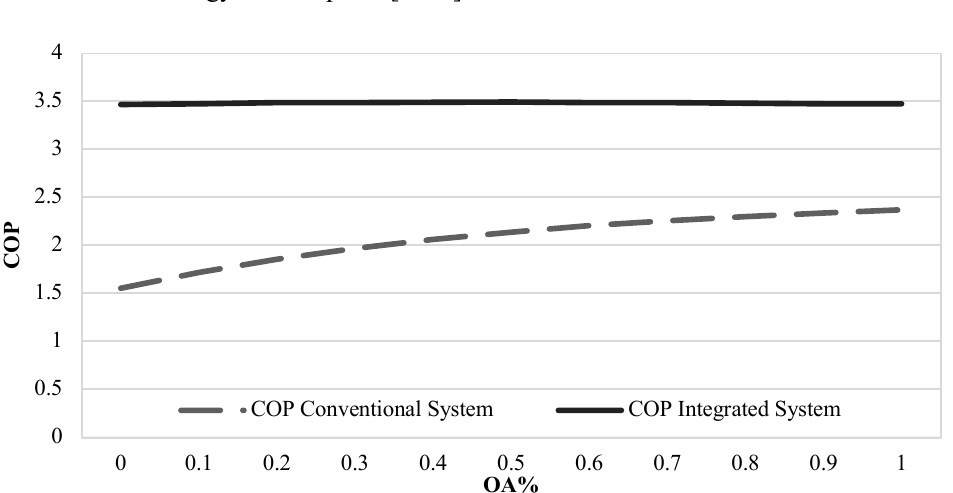
Figure 4. Coefficient of